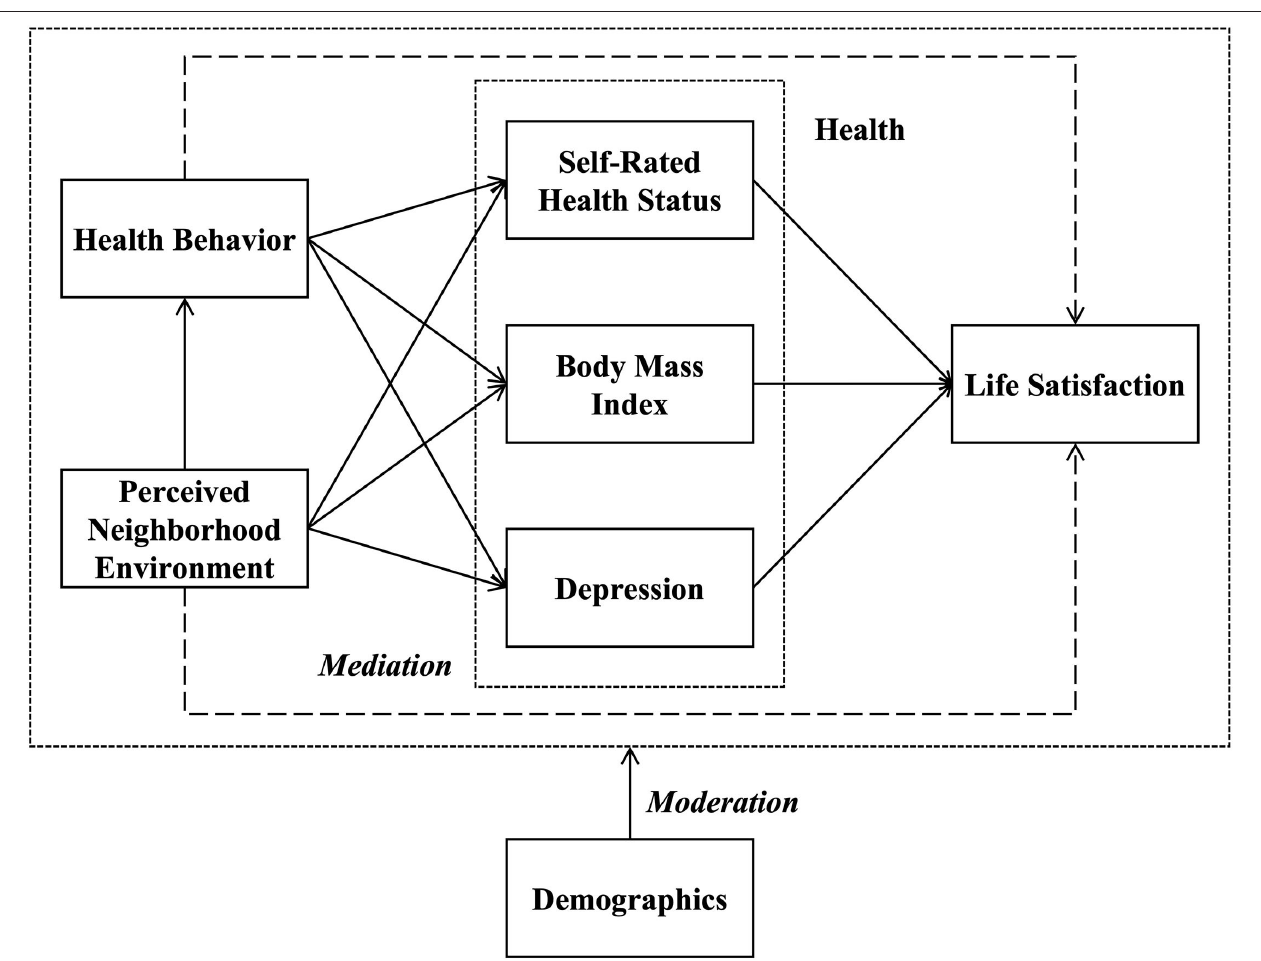
FIGURE 1 | Conceptual